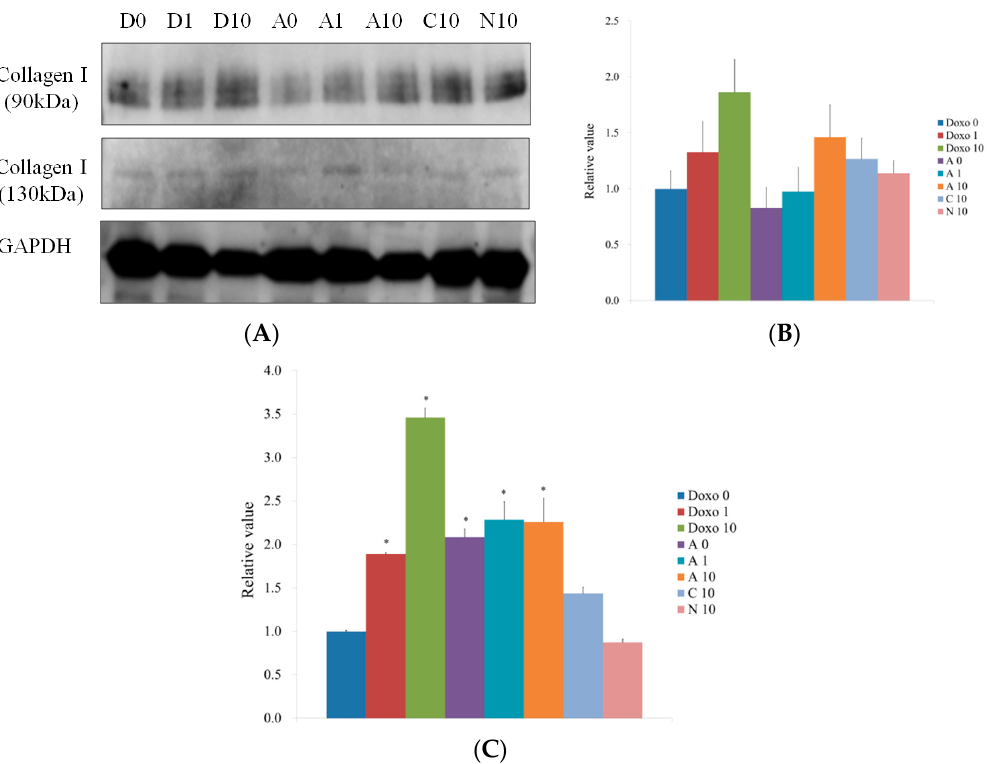
Figure 6. ( A ) Western blot analysis to detect the collagen I protein expressions of spheroids grown in osteogenic media on Day 7. ( B ) Quantitative results of Western blot analysis of collagen I (90 kDa). ( C ) Quantitative results of Western blot analysis of collagen I (130 kDa). * Statistically significant differences were seen when compared with the data from the doxorubicin 0 μ g/mL (Doxo0) group ( p < 0.05).